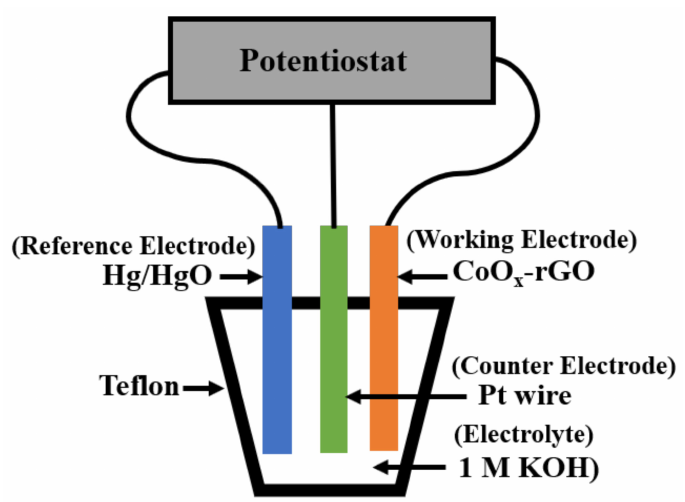
Figure 2. Schematic representation of the three-electrode measurement